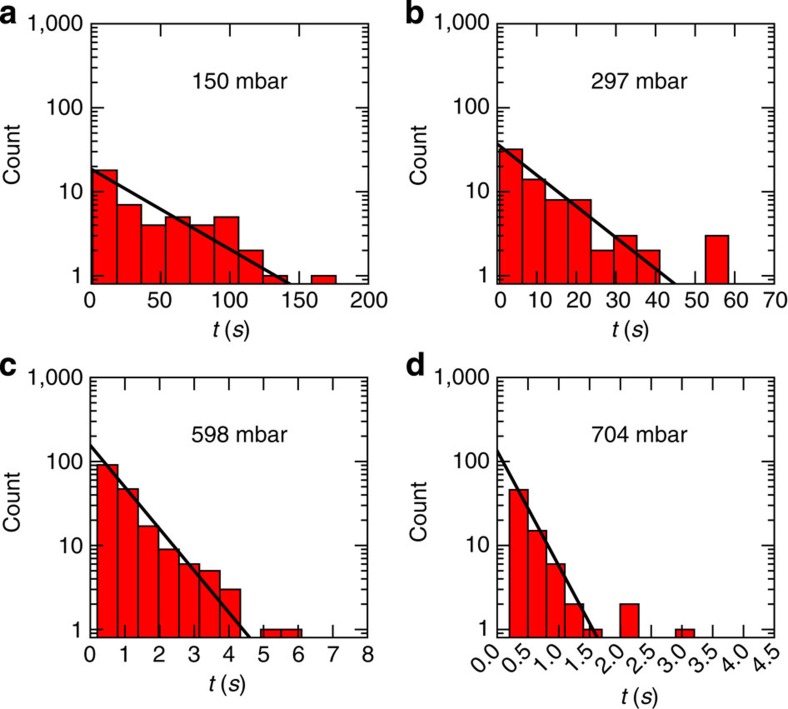
Example distributions of waiting times in a groove.Measured waiting times in nanogrooves separated by nanoslits of width
ws=0.4 μm (chip 1 below) for
different values of the pressure difference imposed over the chip, spanning
most of the parameter range explored in experiments here. Histograms shown
agree well with single exponential fits (solid lines—obtained from
maximum likelihood estimation, see Methods). Apparent ‘outliers'
arise from finite statistics in the tails and should be there, as their
numbers agree with the expected numbers given by the areas under the tails
of the theoretical distributions. Numbers of measured transition events are
(a) 47, (b) 72, (c) 180 and (d) 73.